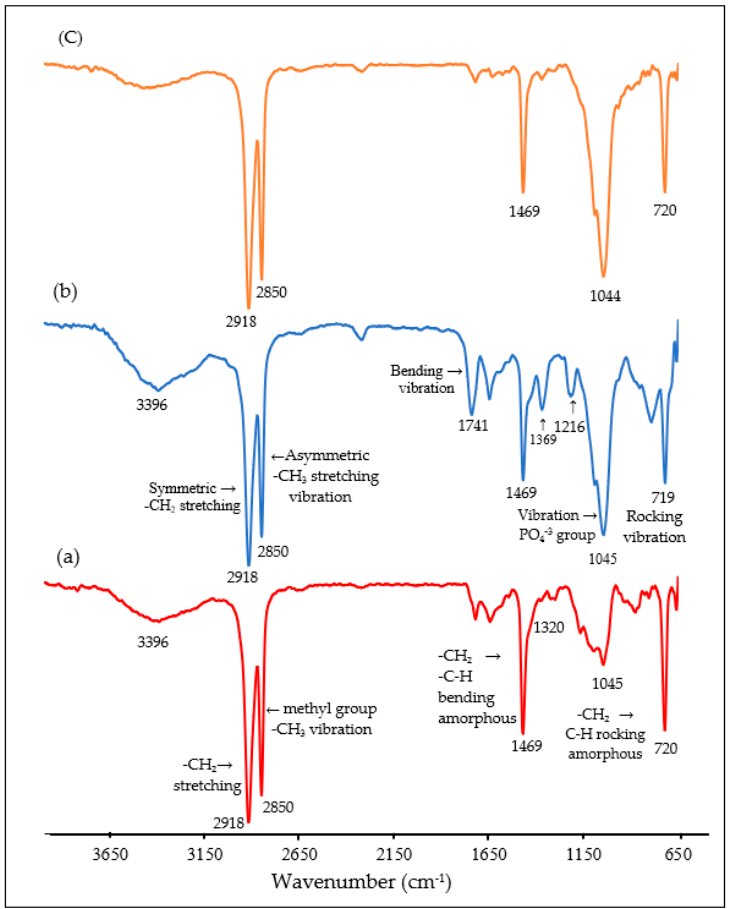
Figure 2. Fourier transform infrared (FTIR) spectra of (a) Pure HDPE, (b) Untreated HDPE/30HAp composite, and (c) Treated HDPE/30HAp-S composite.